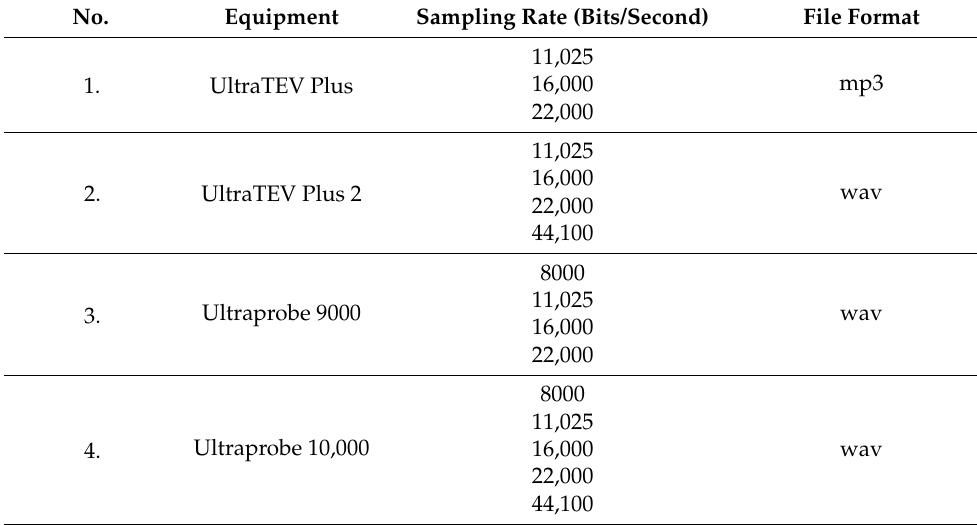
Table 3. List of equipment and sampling rates.